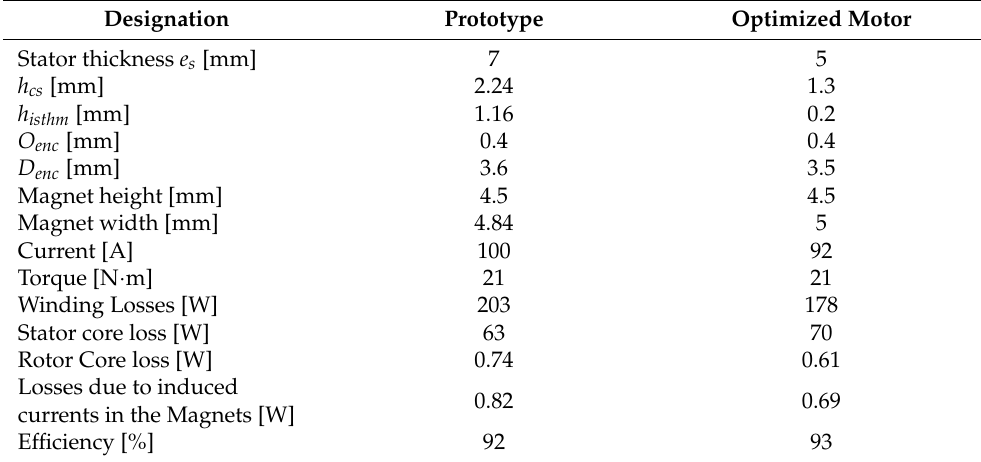
Table 4. Comparison between the prototype and the optimized motor.